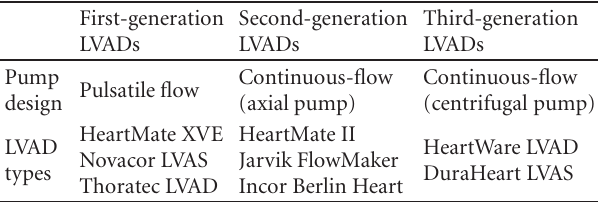
Table 2: Clinically used adult LVAD